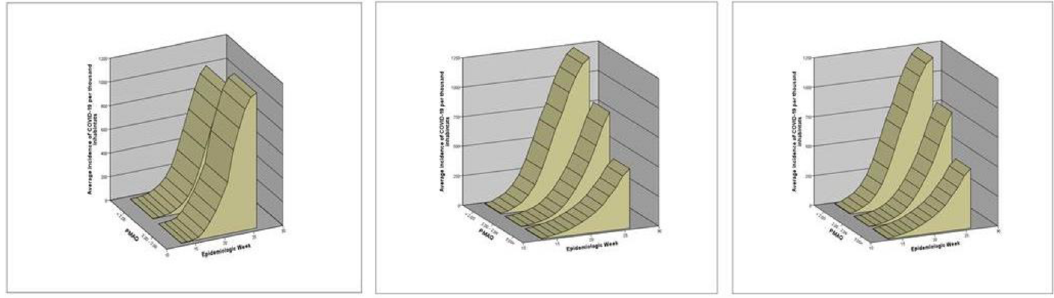
Fig 3. Evolution of the incidence of COVID-19 cases per 100 thousand inhabitants in Brazilian cities until the 26th epidemiological week stratified by PMAQ score when the PHC coverage is less than 50% (A), 50–70% PHC coverage (B) and&gt;70% PHC coverage